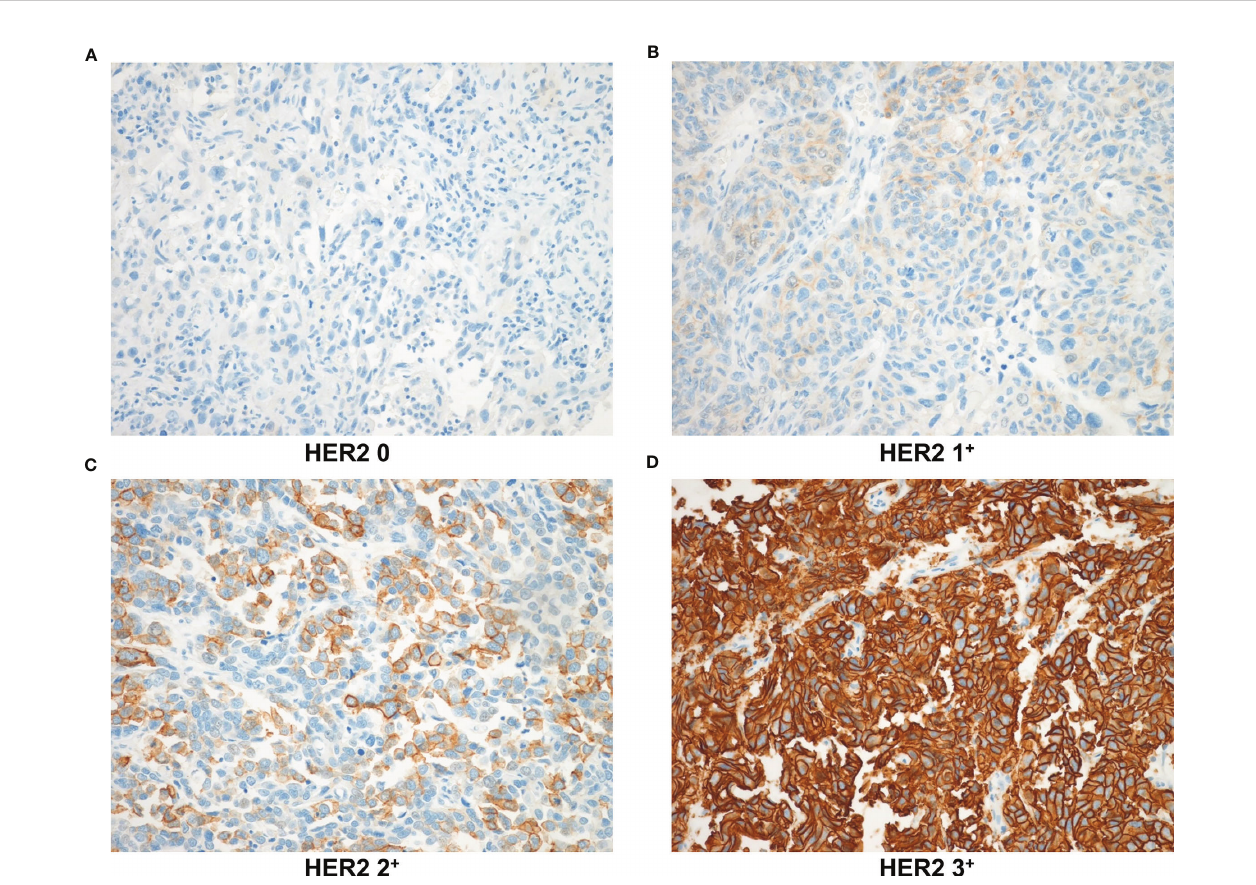
FIGURE 2 | HER2 expression levels based on immunohistochemical staining were observed at 200× magni fi cation. (A) HER2 0: no staining (B) HER2 1 + : faint or partial membrane staining in ≤ 10% of tumor cells (C) HER2 2 + : weak or moderate complete membrane staining in >10% of tumor cells (D) HER2 3 + : strong complete membrane staining in >10% of tumor cells. HER2, human epidermal growth factor